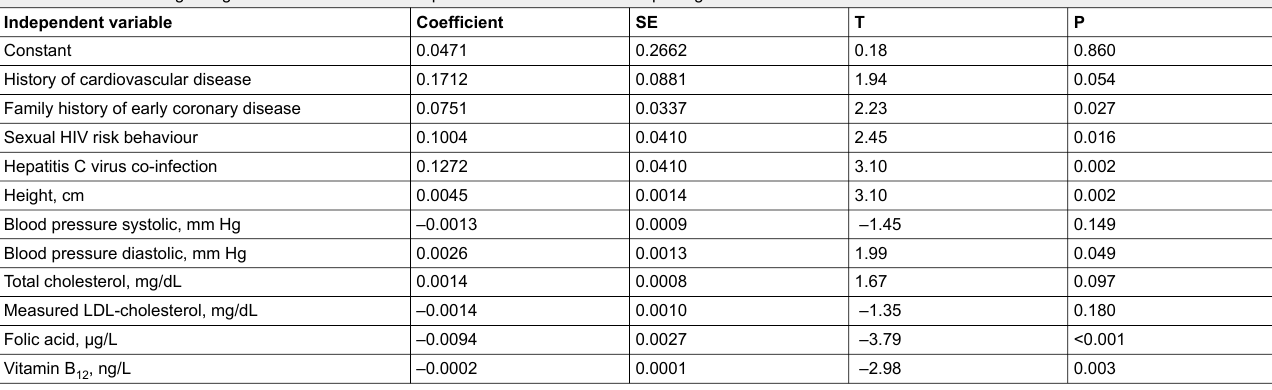
Table 3: Information regarding the coefficients of the independent variables of the multiple regression model*. Independent